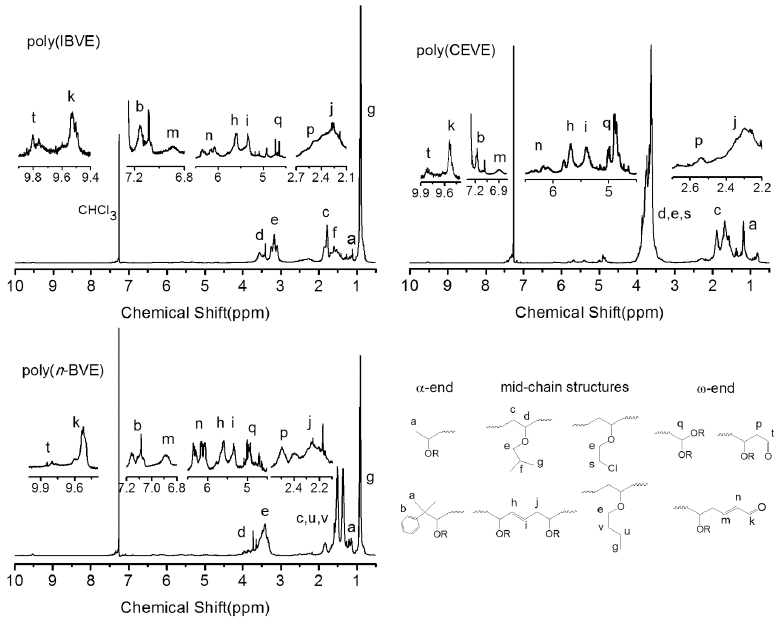
Figure 8. 1 H-NMR spectra of poly(IBVE), poly(CEVE), and poly( n -BVE) initiated by CumOH/ B(C 6 F 5 ) 3 /Et 2 O in aqueous media.